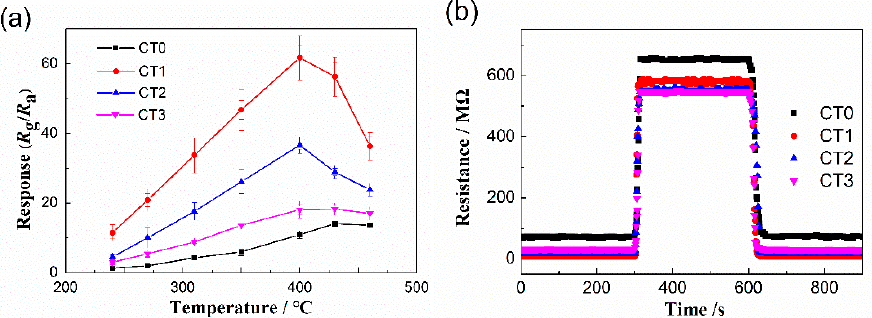
Figure 5. Gas sensing performances of the as-prepared products. ( a ) Gas sensitivity; ( b ) Response and recovery curves at 400 °C.